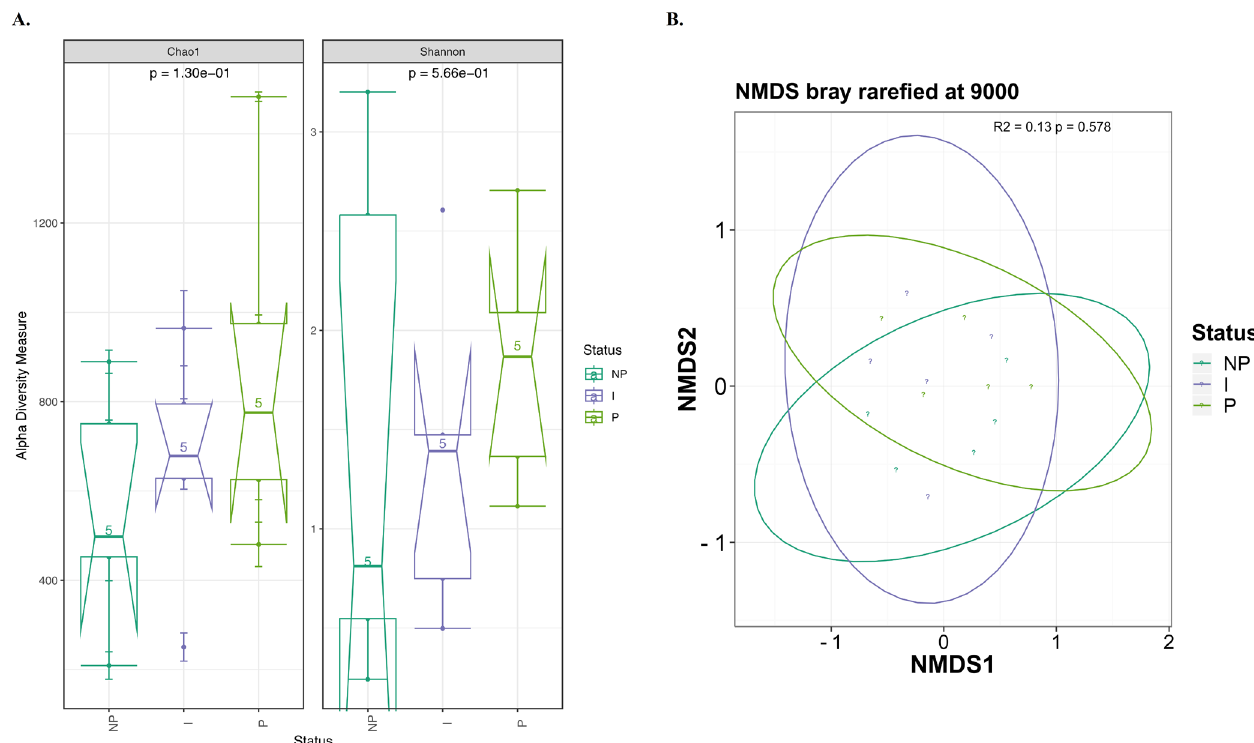
Figure 4. Alpha and beta diversity of fungal composition of nasal samples. ( A ) Alpha-diversity, measured by Chao1 and Shannon diversity Index is plotted for individuals with different S. aureus carrier status: non-carriers (NP, dark green), intermittent carriers (I, purple) and persistent carriers (P, light green). The Chao1 index (left panel) and Shannon index (right panel) were computed for 15 subjects. The line inside the box represents the median, while the whiskers represent the lowest and highest values within the 1.5 interquartile range (IQR). Statistical testing showed no significant differences among the groups: Chao1 p = 0.13; Shannon p = 0.566. ( B ) Comparison of beta-diversity of fungal composition between S. aureus carriage groups with NMDS ordinance calculated from Bray–Curtis distance estimation. I: Intermittent, NP: non-carrier, P: